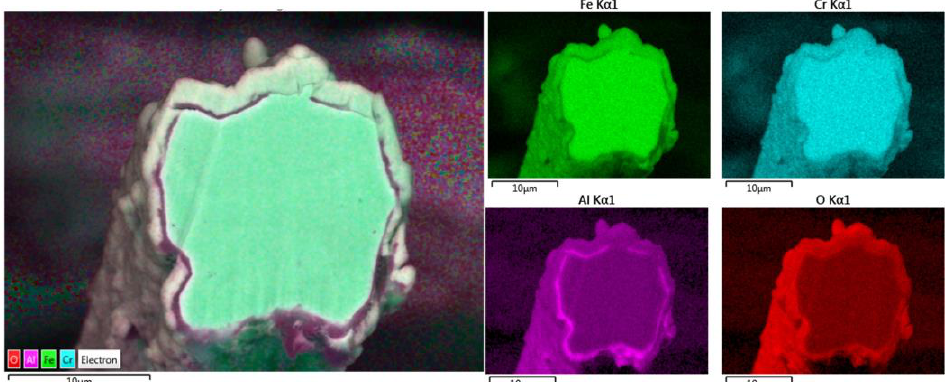
Figure 8. Elemental EDS mapping of Fe, Cr, Al, and O of a 12 µ m FeCrAl fiber after one MSHT cycle.